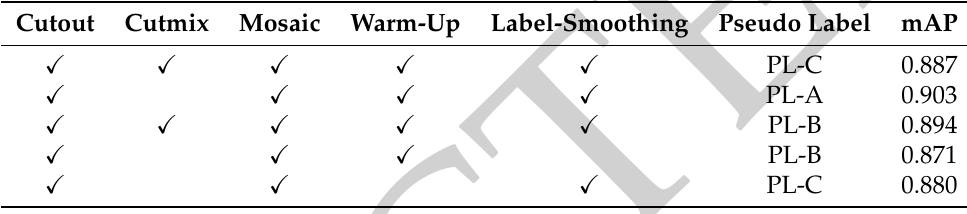
Table 3. Ablation experiment results on WDT1024.